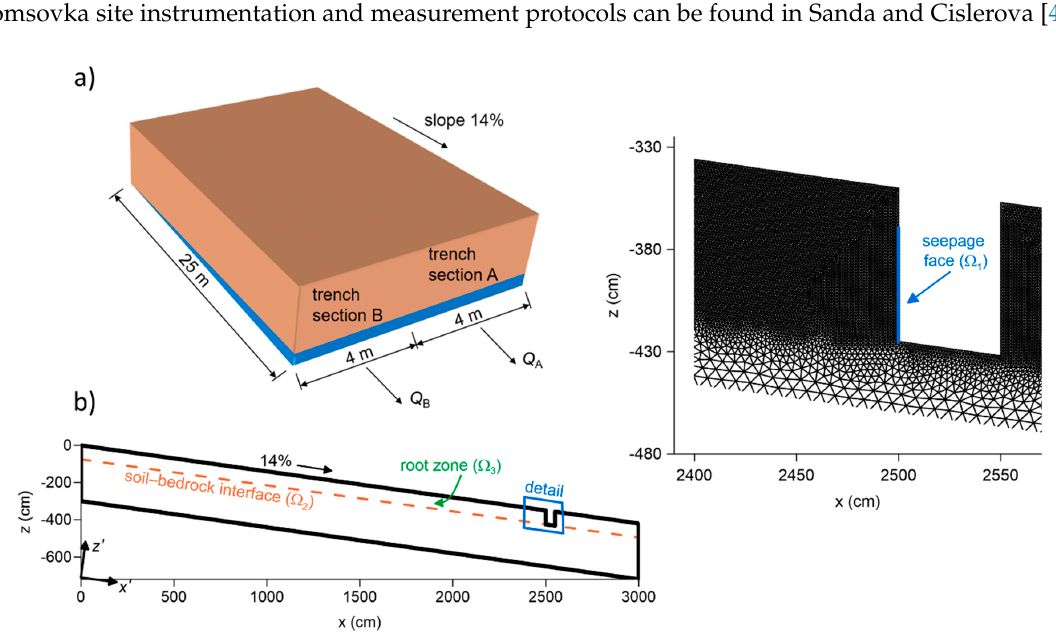
Figure 1. Two-dimensional flow domain representing the hillslope segment at the Tomsovka experimental site: ( a ) schematics of the hillslope segment with the experimental trench for collecting subsurface hillslope discharge ( b ) flow domain with the detail of the subsurface trench.